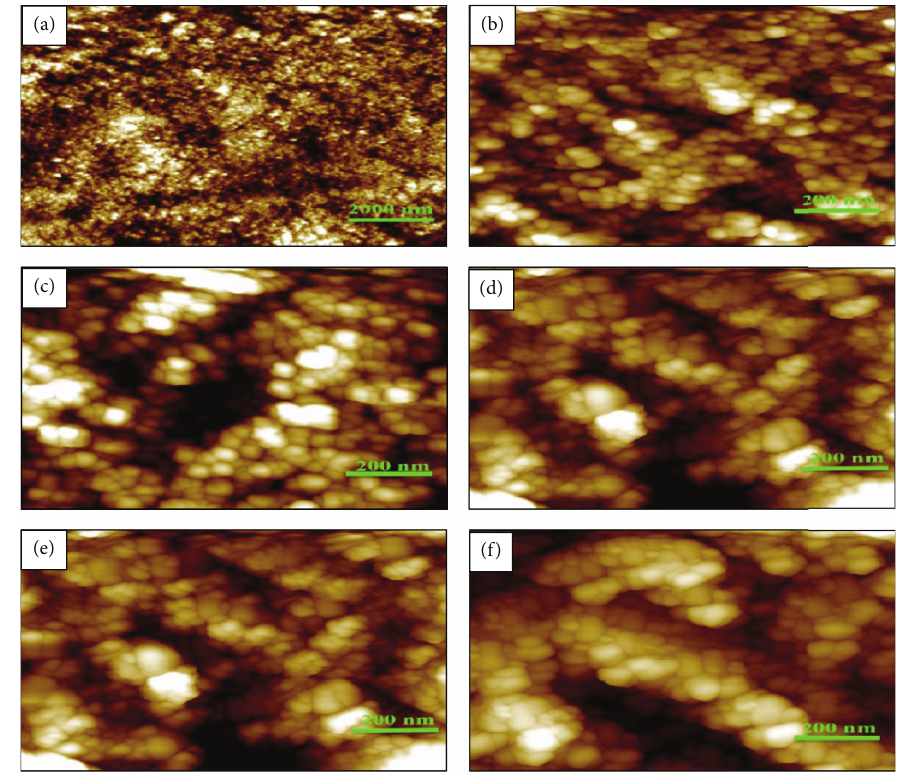
Figure 1: AFM/STM images of TiO 2 film with different wt% of carbon black.